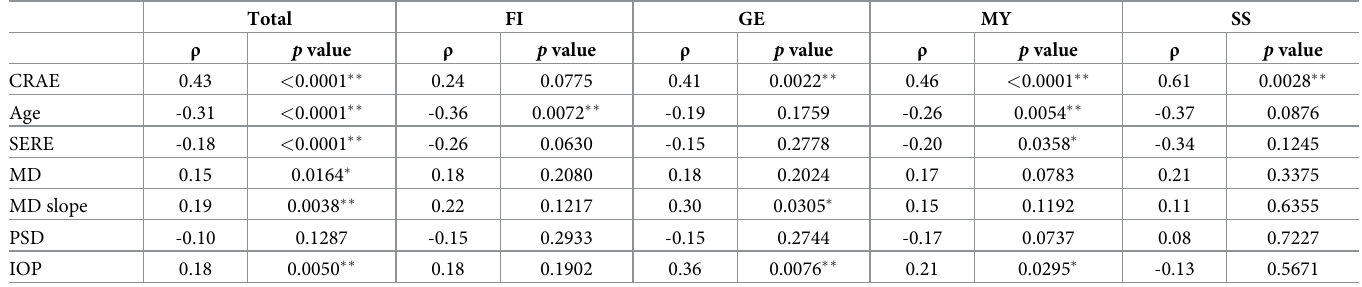
The p values and correlation coefficients ( ρ ) between CRVE and each parameter were calculated using the Spearman’s rank correlation coefficient test in each disc appearance group. � and �� indicate p < 0.05 and p < 0.01,